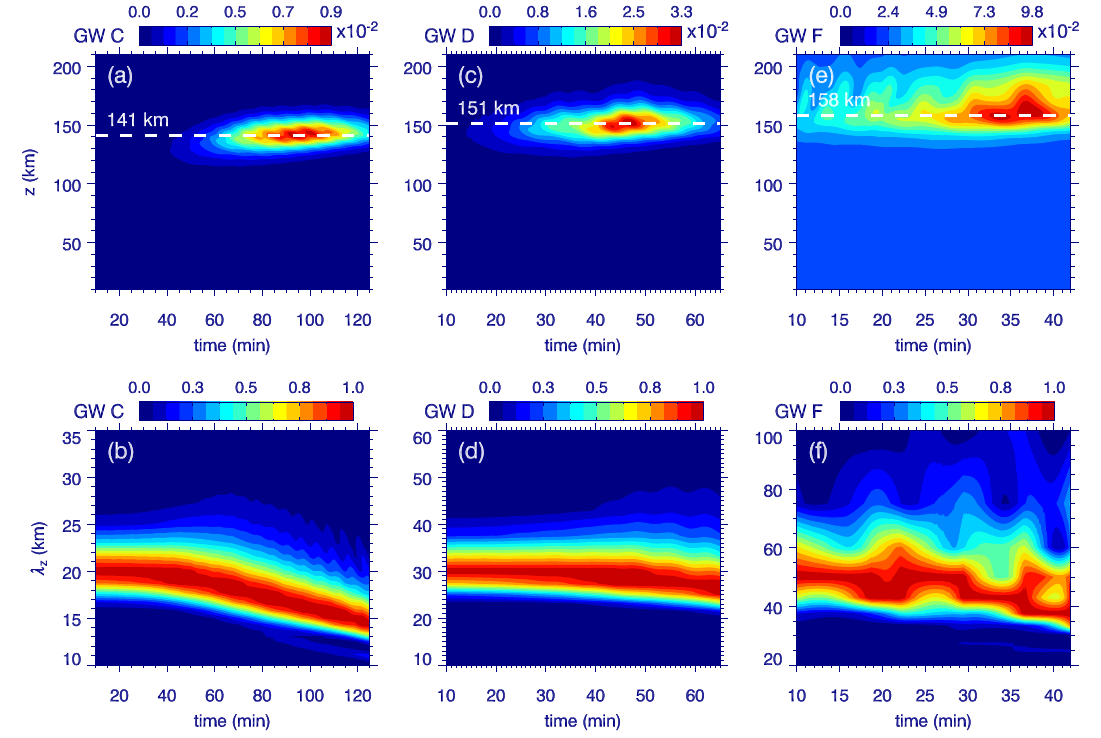
Fig. 5. Same as Fig. 4, but for the GWs with initial (GW C, left column) λ z = 20km, (GW D, middle column) λ z = 30km, and (GW F, right column) λ z = 50km propagating in the isothermal atmosphere with Pr =